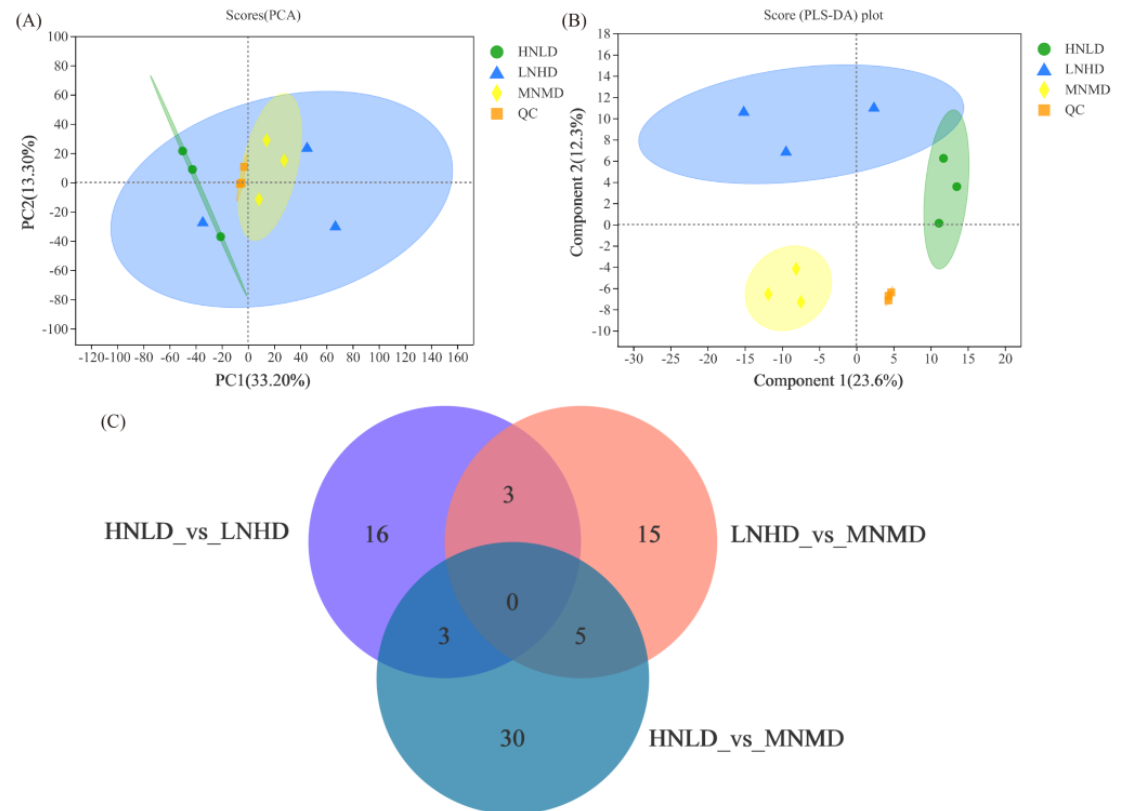
Figure 1. PCA, PLS − DA, and Venn diagram analysis of rice under different nitrogen fertilizers and planting densities: ( A ) PCA, ( B ) PLS − DA, and ( C ) Venn diagram analysis.